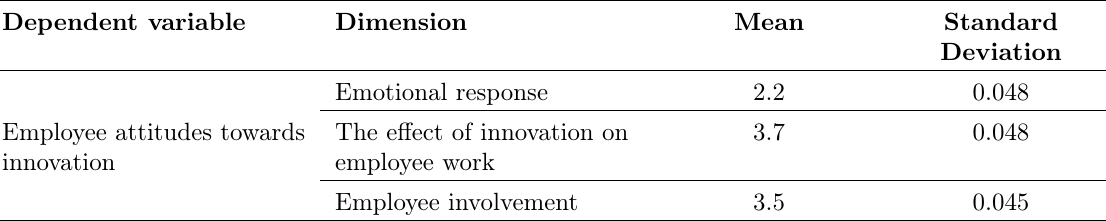
Table 1. Descriptive statistics of the dimension of dependent